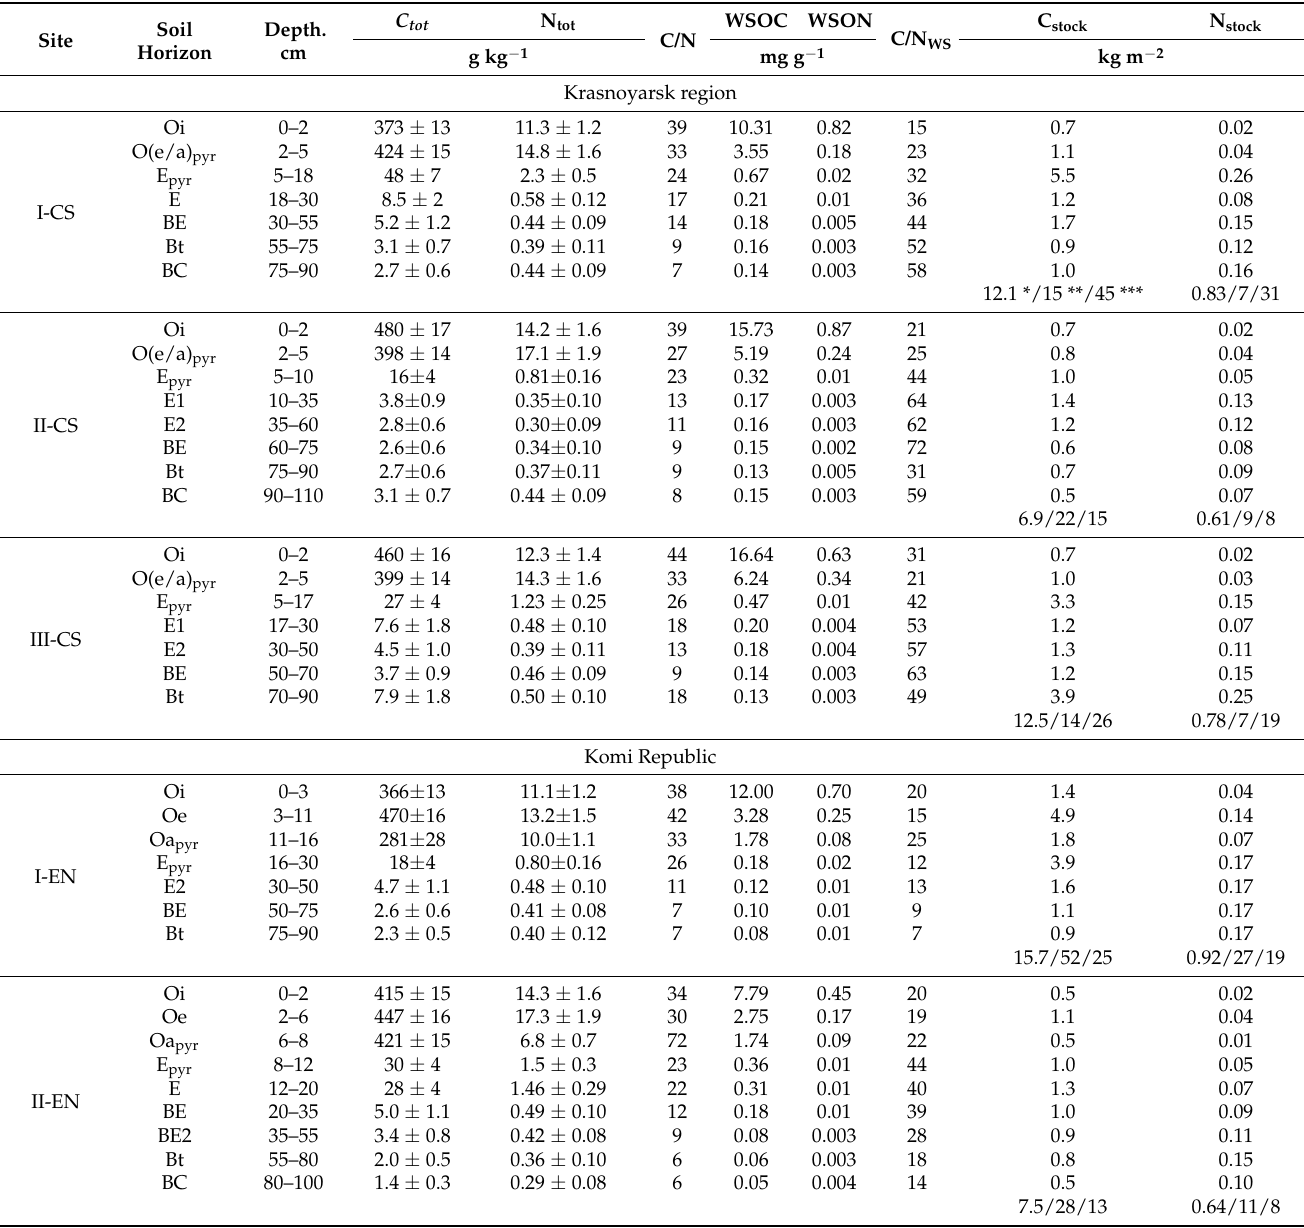
Table 3. Carbon and nitrogen contents in the studied